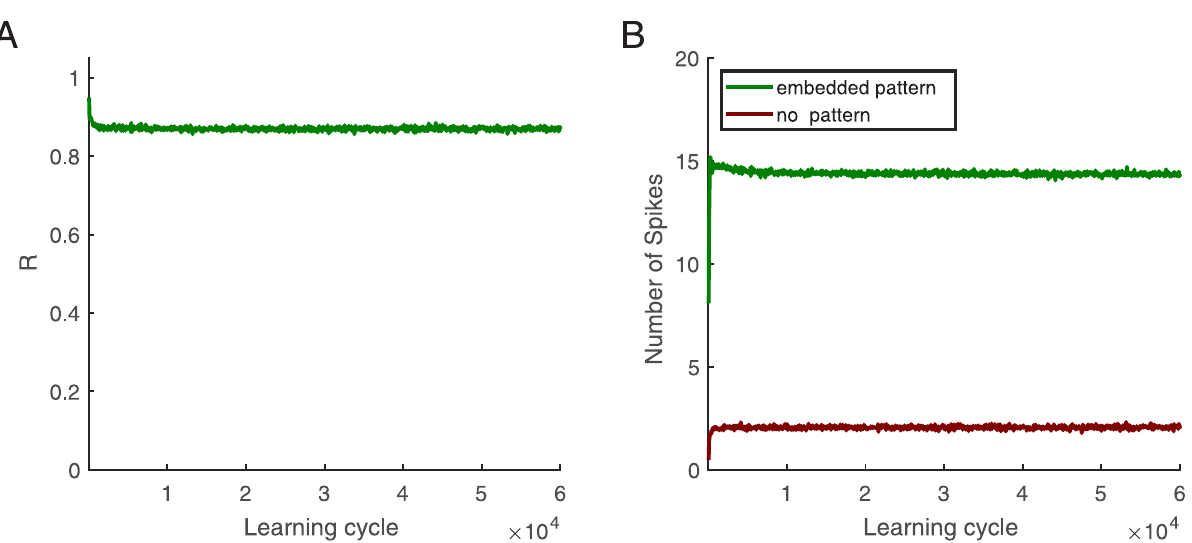
Fig 4. Long term robustness of memory traces. (A) R as memory criterion versus learning cycle: Without learned patterns in afferents, learning continues, and every 50 cycles, learning is paused, and the learned pattern is placed in the background, then R is computed as a memory criterion. (B) Number of spikes versus learning cycle. Neuron elicits more spikes when the embedded pattern is in the afferents (green) than the situation without the pattern (red). Patterns duration is 50 ms, shown in afferents starting from 500 ms, L = 15 ms, and this figure is based on an average of 500